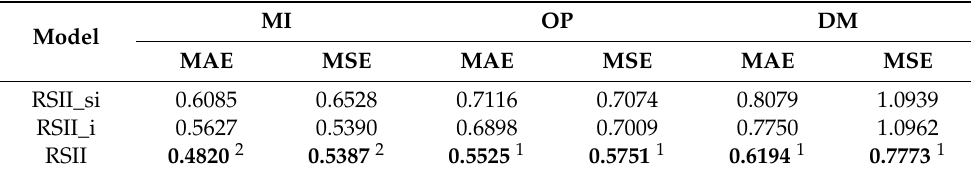
Table 4. Table of experimental results of different modules on the RSII model.